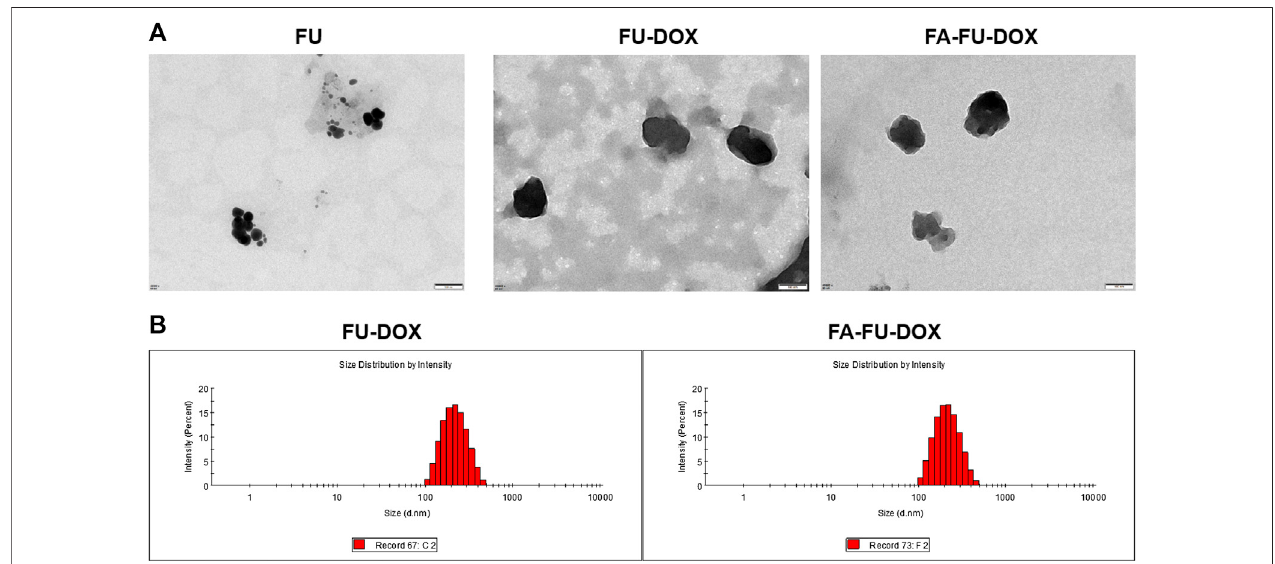
FIGURE 3 | The characterization of FU-DOX and FA-FU-DOX. (A) Transmission electron microscopy (TEM) images of FU, FU-DOX, and FA-FU-DOX. (B) Particle size distributions of FU-DOX and FA-FU-DOX.